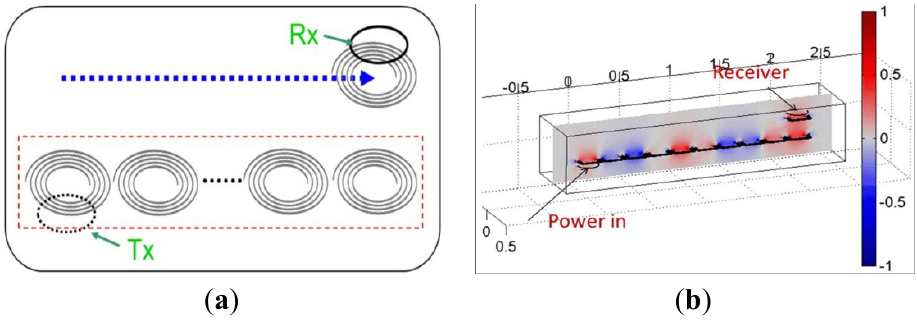
Figure 5. ( a ) System architecture with multi-relay coils. One resonant coil acts as the transmitter and one resonant coil acts as the receiver. This system can be used to extend transfer distance or power mobile objects; ( b ) Magnetic field distribution of system architecture with multi-relay coils. The two marked coils act as the transmitter and the receiver, the color strength shows the distribution situation of magnetic